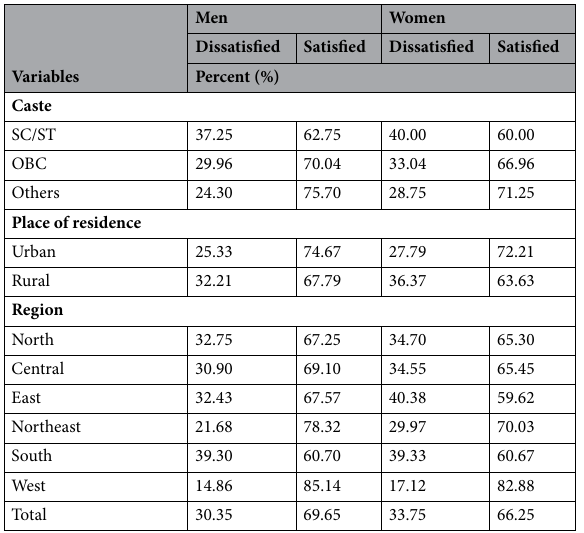
Table 2. Bivariate estimates for life satisfaction by background characteristics among older adults, LASI Wave 1, 2017–18. % Weighted percentage, Individual sampling weights given in LASI wave 1, 2017–18 were applied. SRH self-rated health, ADL activities of daily living, IADL instrumental activities of daily living, MPCE monthly per capita consumption expenditure. # Currently unmarried category comprises widowed, divorced, separated, deserted and never married older individuals. ## Category of living with others consists of those older adults who were co-residing either with their spouse and children, living with spouse and other relatives, and living with children and/or other